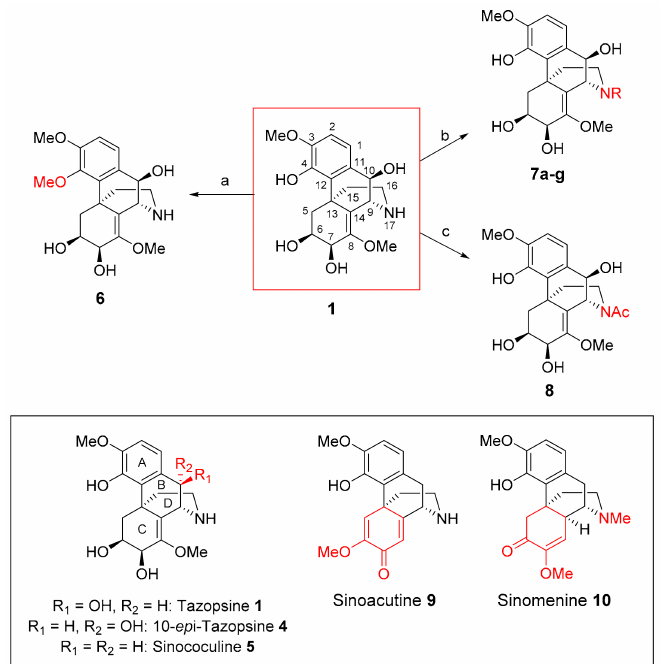
Figure 2. Semisynthetic access to tazopsine derivatives 6 – 8 and structure of natural ent -morphinan alkaloids for SAR generation (morphine numbering). (a) CH 2 N 2 , MeOH, 0 ◦ C, 12 h (39%);